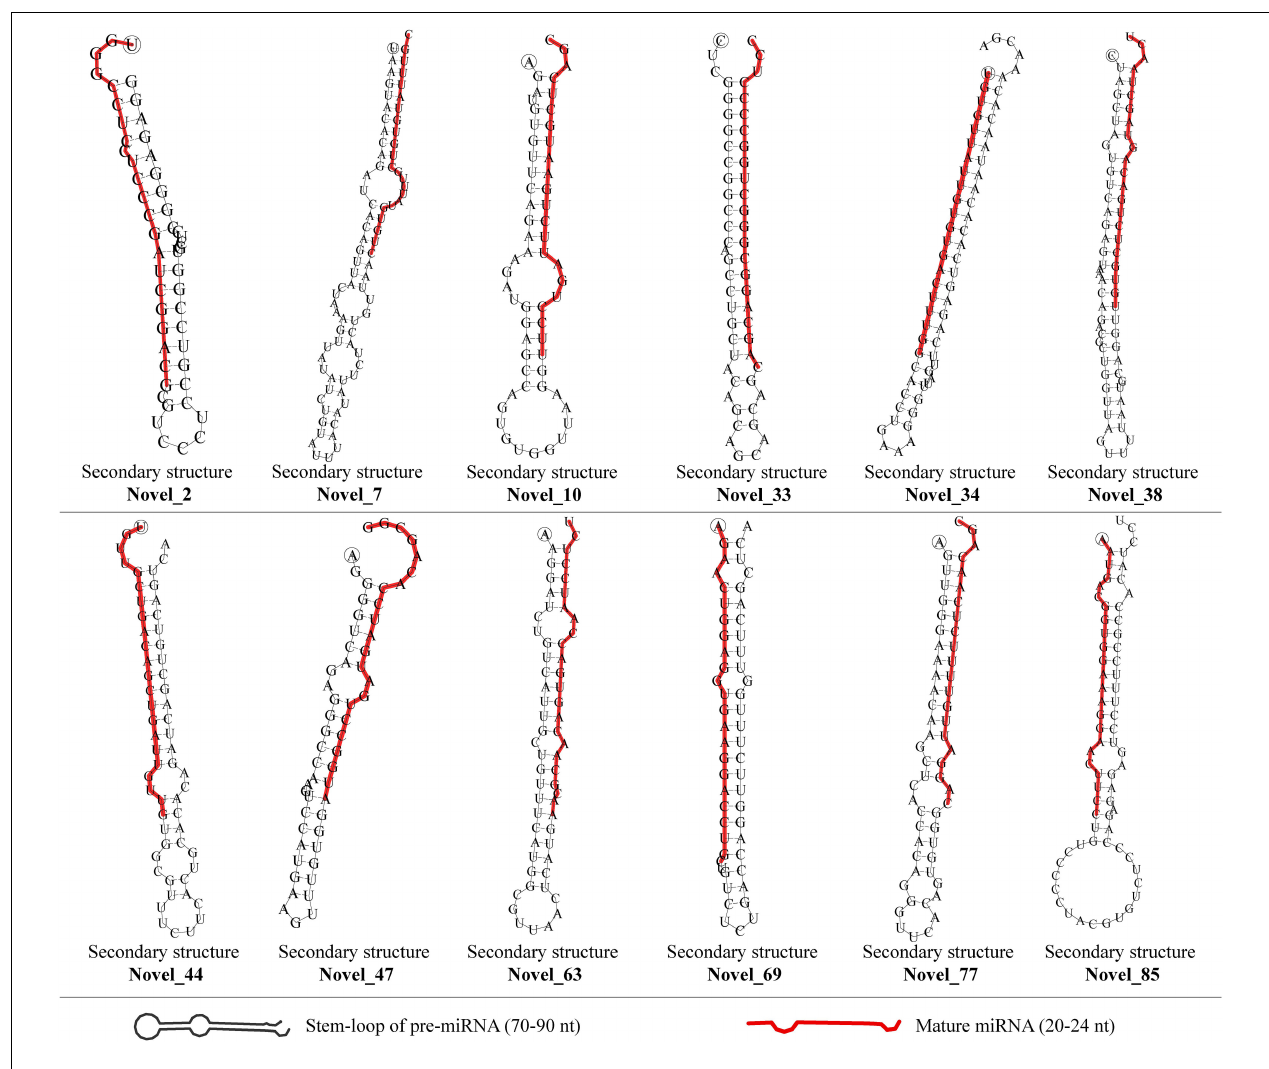
FIGURE 3 | Novel miRNAs and stem-loop structures identified in all